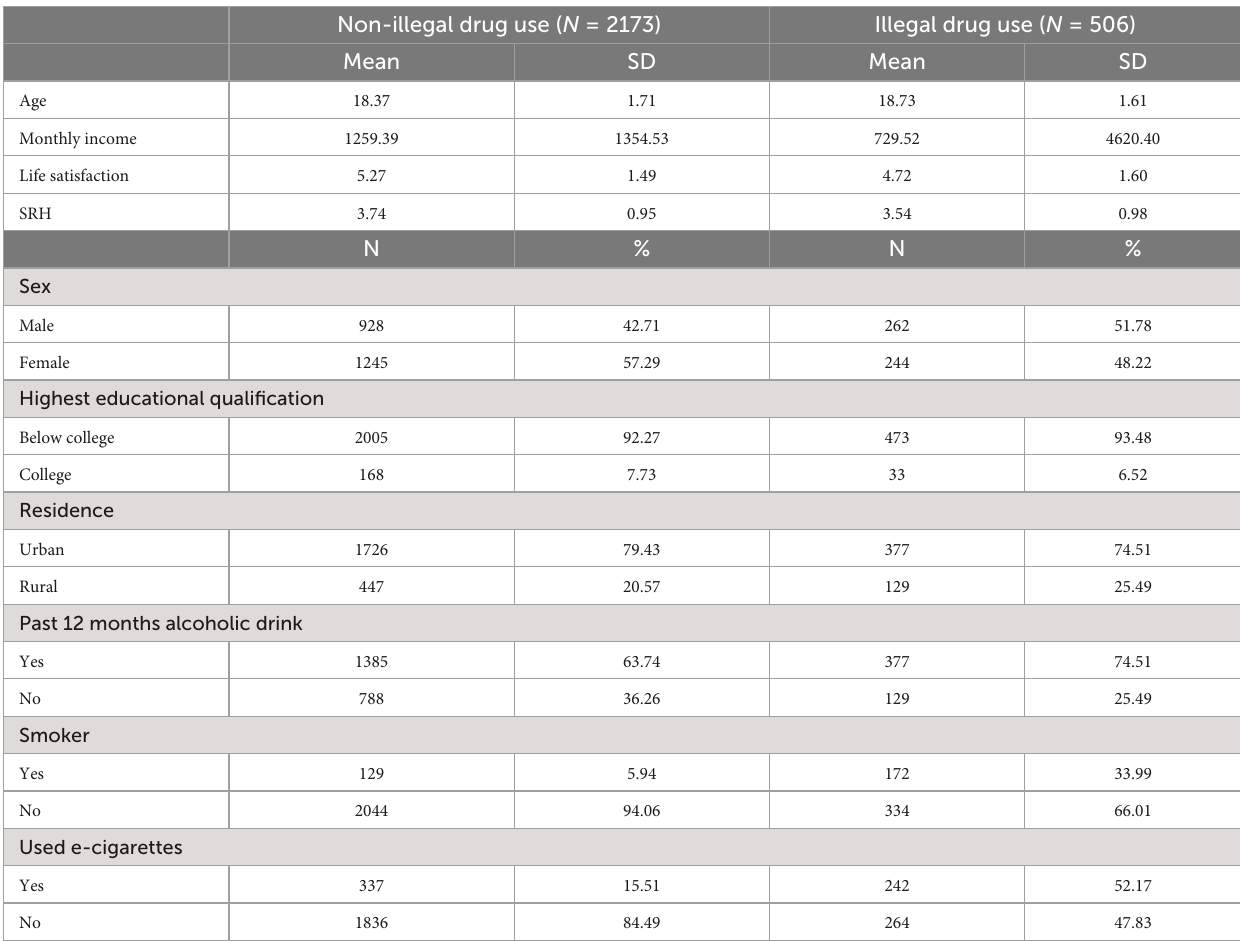
TABLE 1 Descriptive statistics of demographic characteristics, other substance use, life satisfaction, and SRH in non-illegal drug use and illegal drug use.